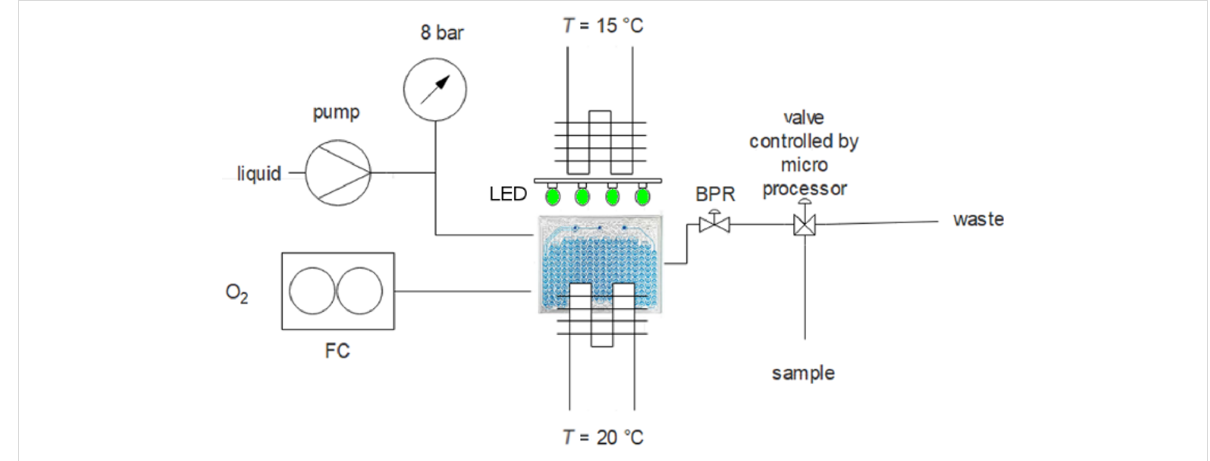
Figure 1: Reaction setup (FC: flow controller, BPR: back pressure